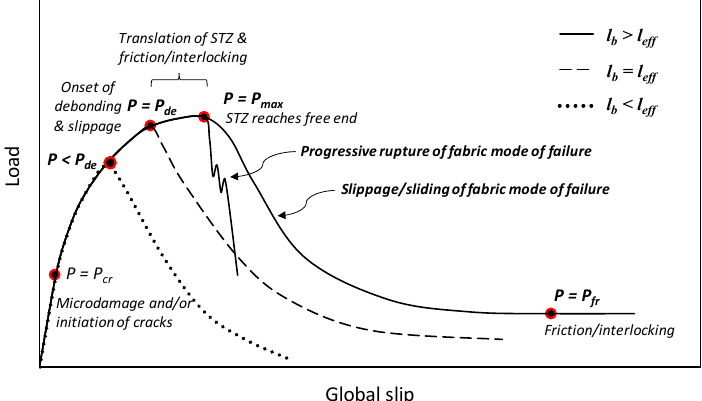
Figure 7. Idealized load - global slip response.